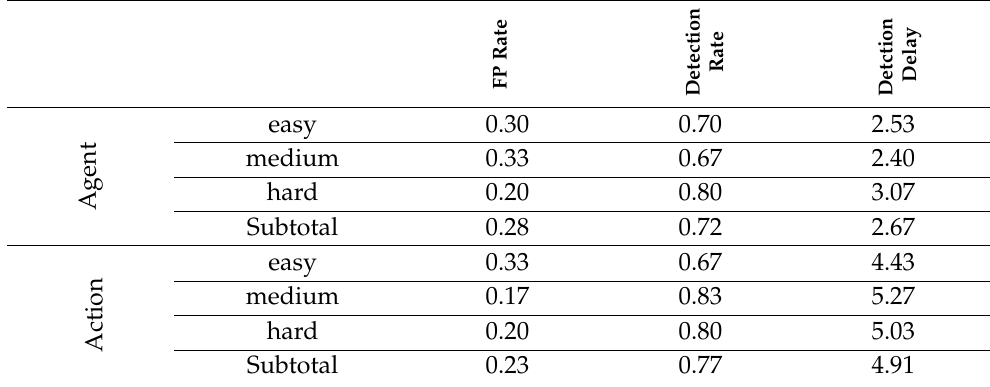
Table 2. Detection performance of Gaussian-based detection in 1&2 step lookahead WOW-agent. With the Gaussian-based novelty detection we see a significant fraction of false positives, and lower correct detection rate compared to the EVT-based detection, both of which are significant. They use the same WOW-agent and so robustness and control performance were not statistically significantly different and are not